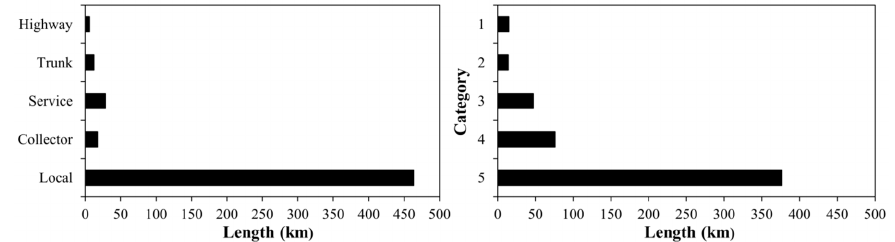
Figure 2. Length of road types and road categories in Talca.